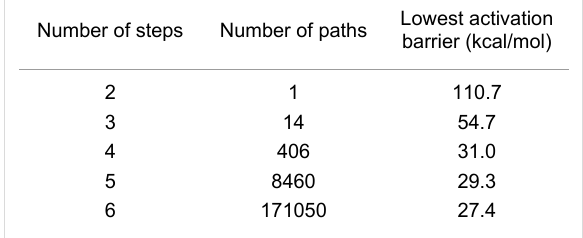
Table 1: The number of pathways found by Lobb corresponding to a certain number of steps in the mechanism and the lowest overall acti- vation barrier necessary for a pathway with that number of steps